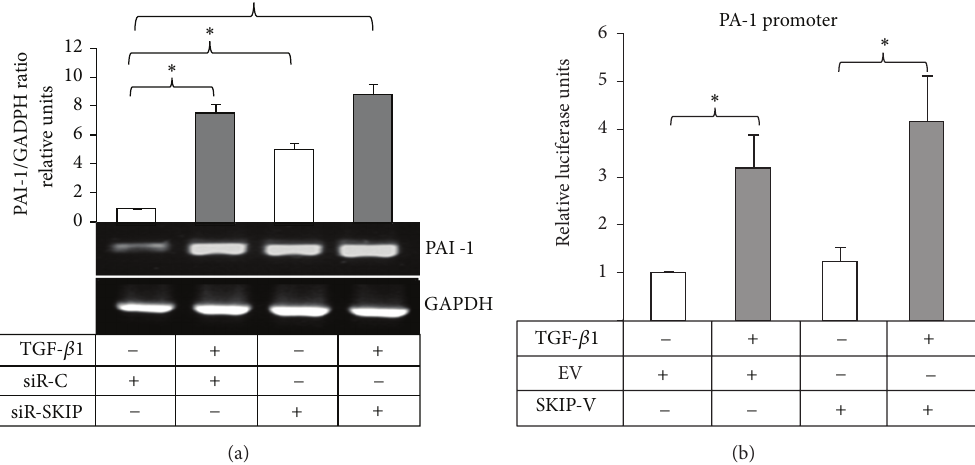
Figure3: Effect ofSKIP knockdown on TGF- 𝛽 1-inducedPAI-1expression. (a)Expressionof PAI-1mRNAtranscriptsevaluated byRT-PCRin PC-3 cells transfected with either control siRNA (siR-C) or siRNA-SKIP (siR-SKIP) before and after stimulation (24 h) with TGF- 𝛽 1. GAPDH was amplified as a control for the amount of cDNA present in each sample. (b) Transactivation of PAI-1 promoter in PC-3 cells is transiently transfected with empty vector (EV) as a control or SKIP-Ha tagged expressing vector (SKIP-V). MMP-9 promoter activity was assayed in cells unstimulated and stimulated with TGF- 𝛽 1 for 48 h. 𝛽 -Galactosidase was used as an internal control of